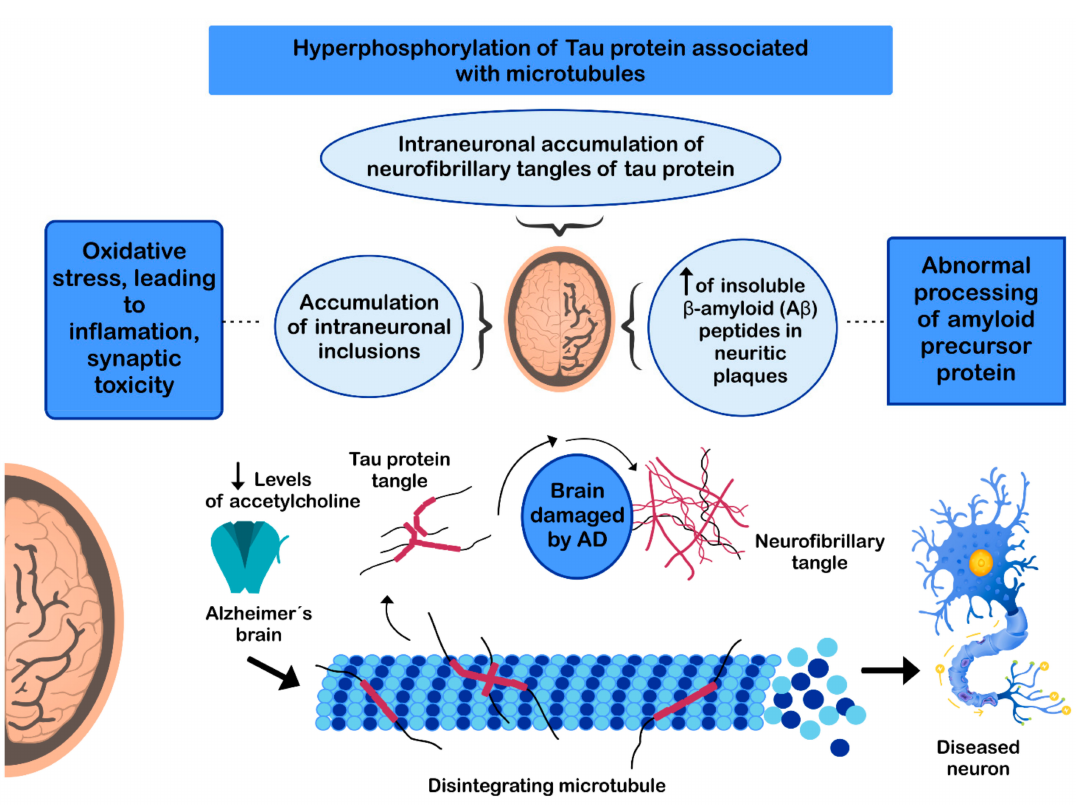
Figure 3. Mechanisms involved in the pathogenesis of Alzheimer’s disease (AD).